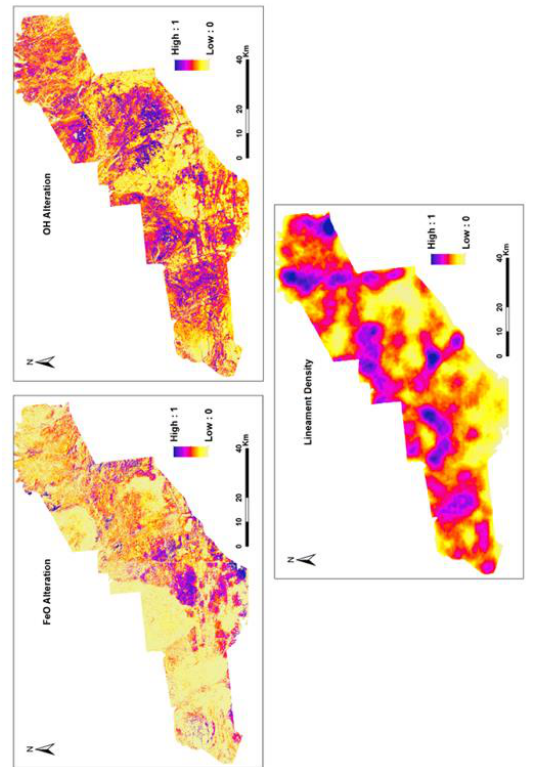
Figure 12. Evidential layers from electromagnetic